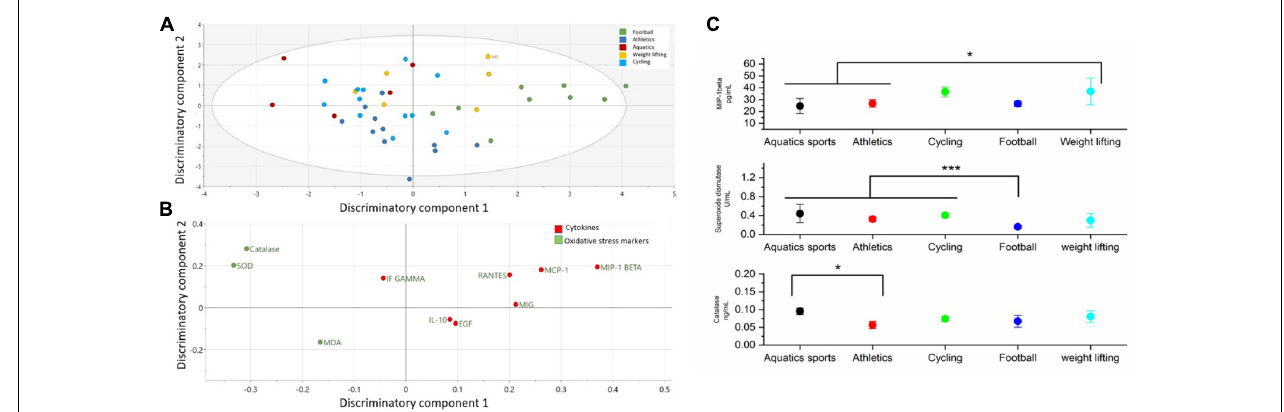
FIGURE 4 | Differences in cytokines and oxidative stress markers among different sport groups. (A) The score plot of OPLS-DA model comparing analytes from five sport groups exhibits two class-discriminatory component 1 ( x -axis) versus class-discriminatory component ( y -axis) 2. (B) The corresponding loading plots shows top associated analytes differentiating five sport groups (C) . Significant differences in cytokines and oxidative stress markers between the two groups by KS test (* p < 0.05).